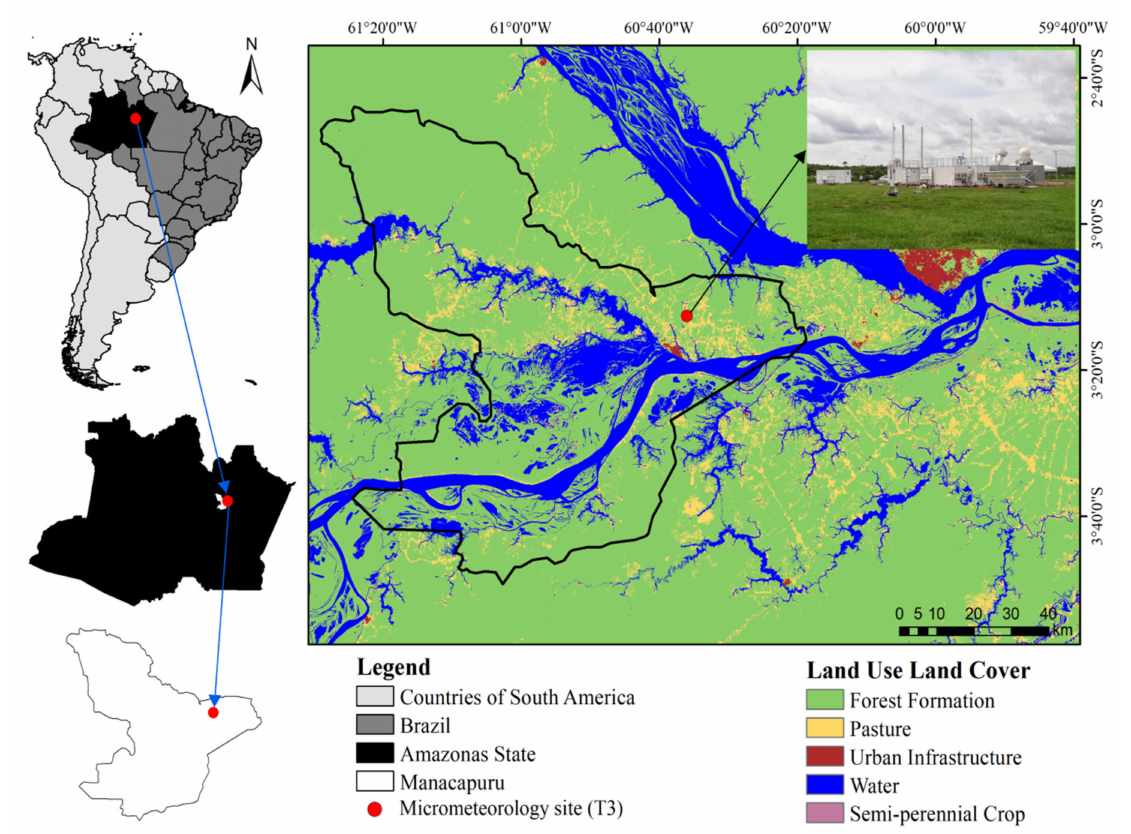
Figure 1. Geographic location of the Municipality of Manacapuru, Amazonas, and the T3 study